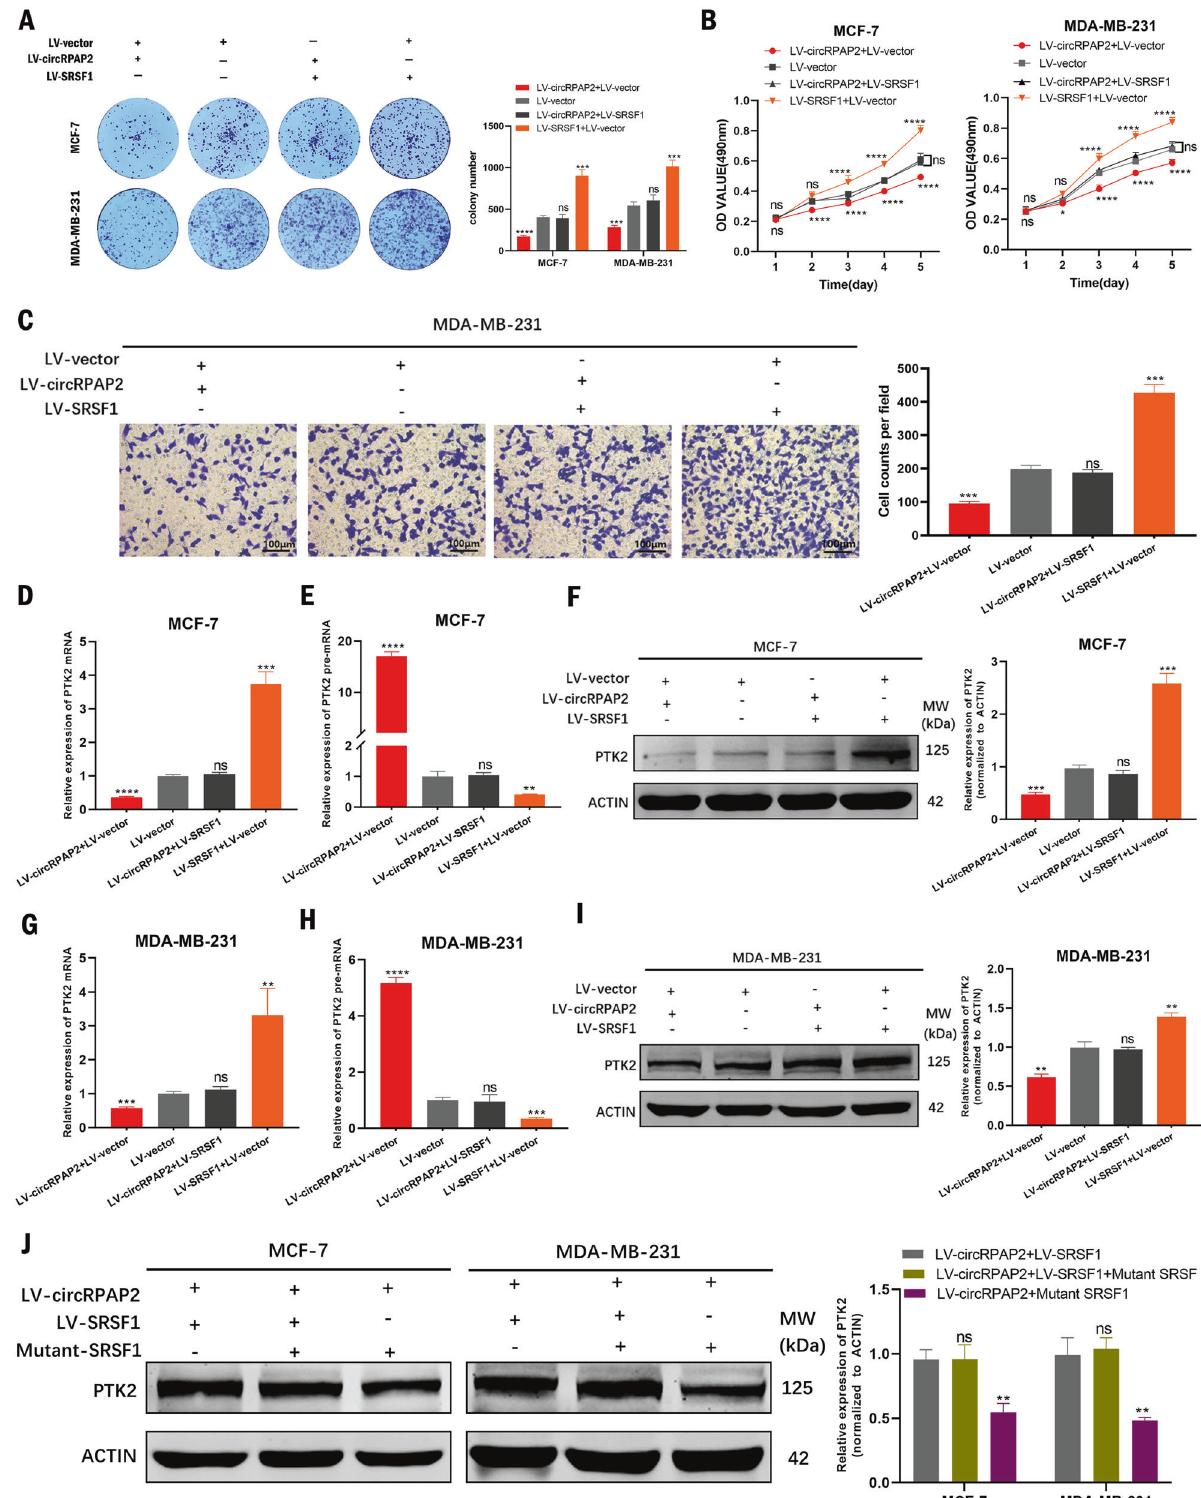
Fig. 6 Rescue assay of the circRPAP2 /SRSF1/PTK2 axis. A – C CircRPAP2 overexpression-induced cell proliferation and migration can be rescued by overexpression of SRSF1 as determined using by colony formation ( A ), MTT ( B ), and Transwell migration assays ( C ). D – I CircRPAP2 overexpression-mediated reduction in PTK2 mRNA and protein expression and increase in PTK2 pre-mRNA could be recovered by overexpressing SRSF1 in BC cells as determined by qRT-PCR and western blotting. J CircRPAP2 overexpression-mediated reduction in PTK2 protein expression could not be recovered by mutant of SRSF1 binding site in BC cells as determined by western blotting. (* P < 0.05, ** P < 0.01, *** P < 0.001, **** P < 0.0001, ns: no signi fi cance).